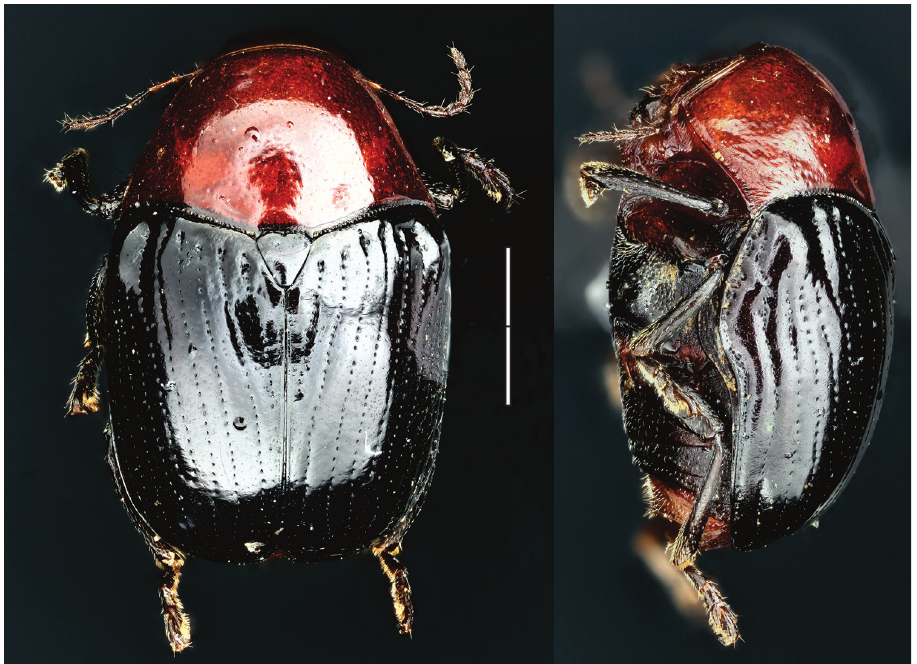
Figure 23. Stegnocephala xanthopyga (Suffrian) (2) , left: habitus (dorsal view), right: habitus (lateral 6. Lexiphanes flavifrons (Burmeister, 1877) (Patagonia, SCZ). 7. Lexiphanes granarius (Suffrian, 1863) (Argentina). 8. Lexiphanes modestus (Boheman, 1858) (Argentina). 9. Lexiphanes nigritulus (Boheman, 1858) (BAS). 10. Lexiphanes ornatipennis (Jacoby, 1908) (TUC).